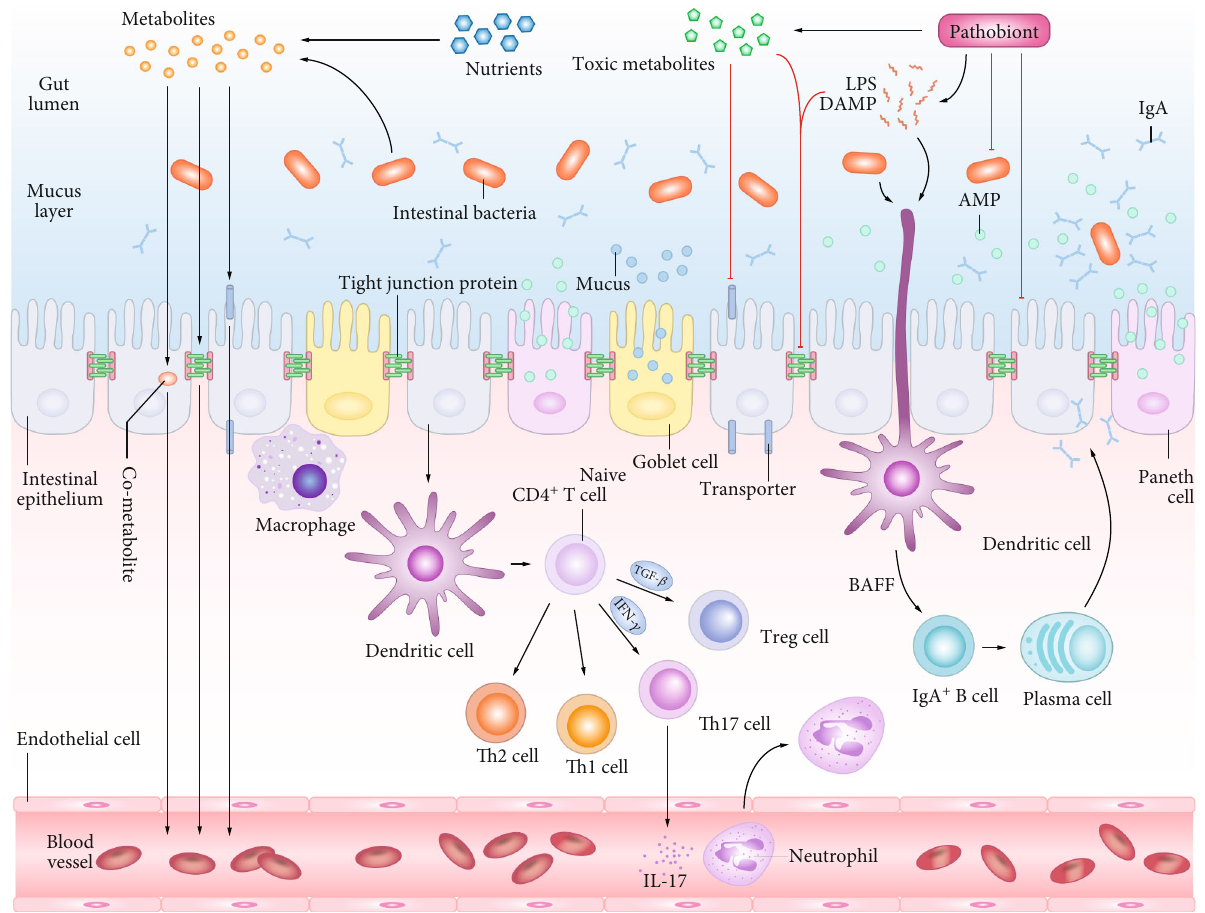
Figure 1: The intestinal epithelial barrier allows a large number of metabolites and immune signals to pass in both directions while blocking the pathways of pathogenic bacteria, toxic metabolites, and microbial byproducts. The outermost layer of the intestinal barrier is the mucus layer which is composed of mucin glycoprotein, AMPs, and sIgA, produced by goblet cells, Paneth cells, and plasma cells, respectively, and excludes the microbiome from the epithelial surface. Adjacent cells are linked together by the tight junction protein families that can determine the permeability and prevent mechanical disruption of the epithelial sheet. The intestinal immune system is established and mature with the participation of the gut microbiota. Once bound to luminal antigens, DC pattern recognition receptors express costimulatory molecules and cellular factors involved in regulating Th1, Th2, Th17, and Treg cells di ff erentiated from naive CD4 + T cells, maintaining Treg/Th17 balance and forming immune homeostasis. The intestinal microbiome promotes the di ff erentiation of IgA- secreting plasma cells by activating APRIL (a proliferation-inducing ligand) receptor and B cell-activating factor in